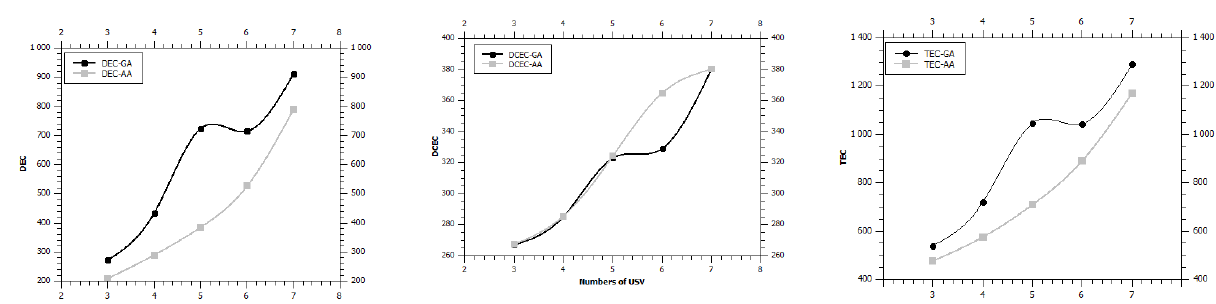
Figure 18: Displacement – energy con- sumption in a zone with a strong degrees of dirt.